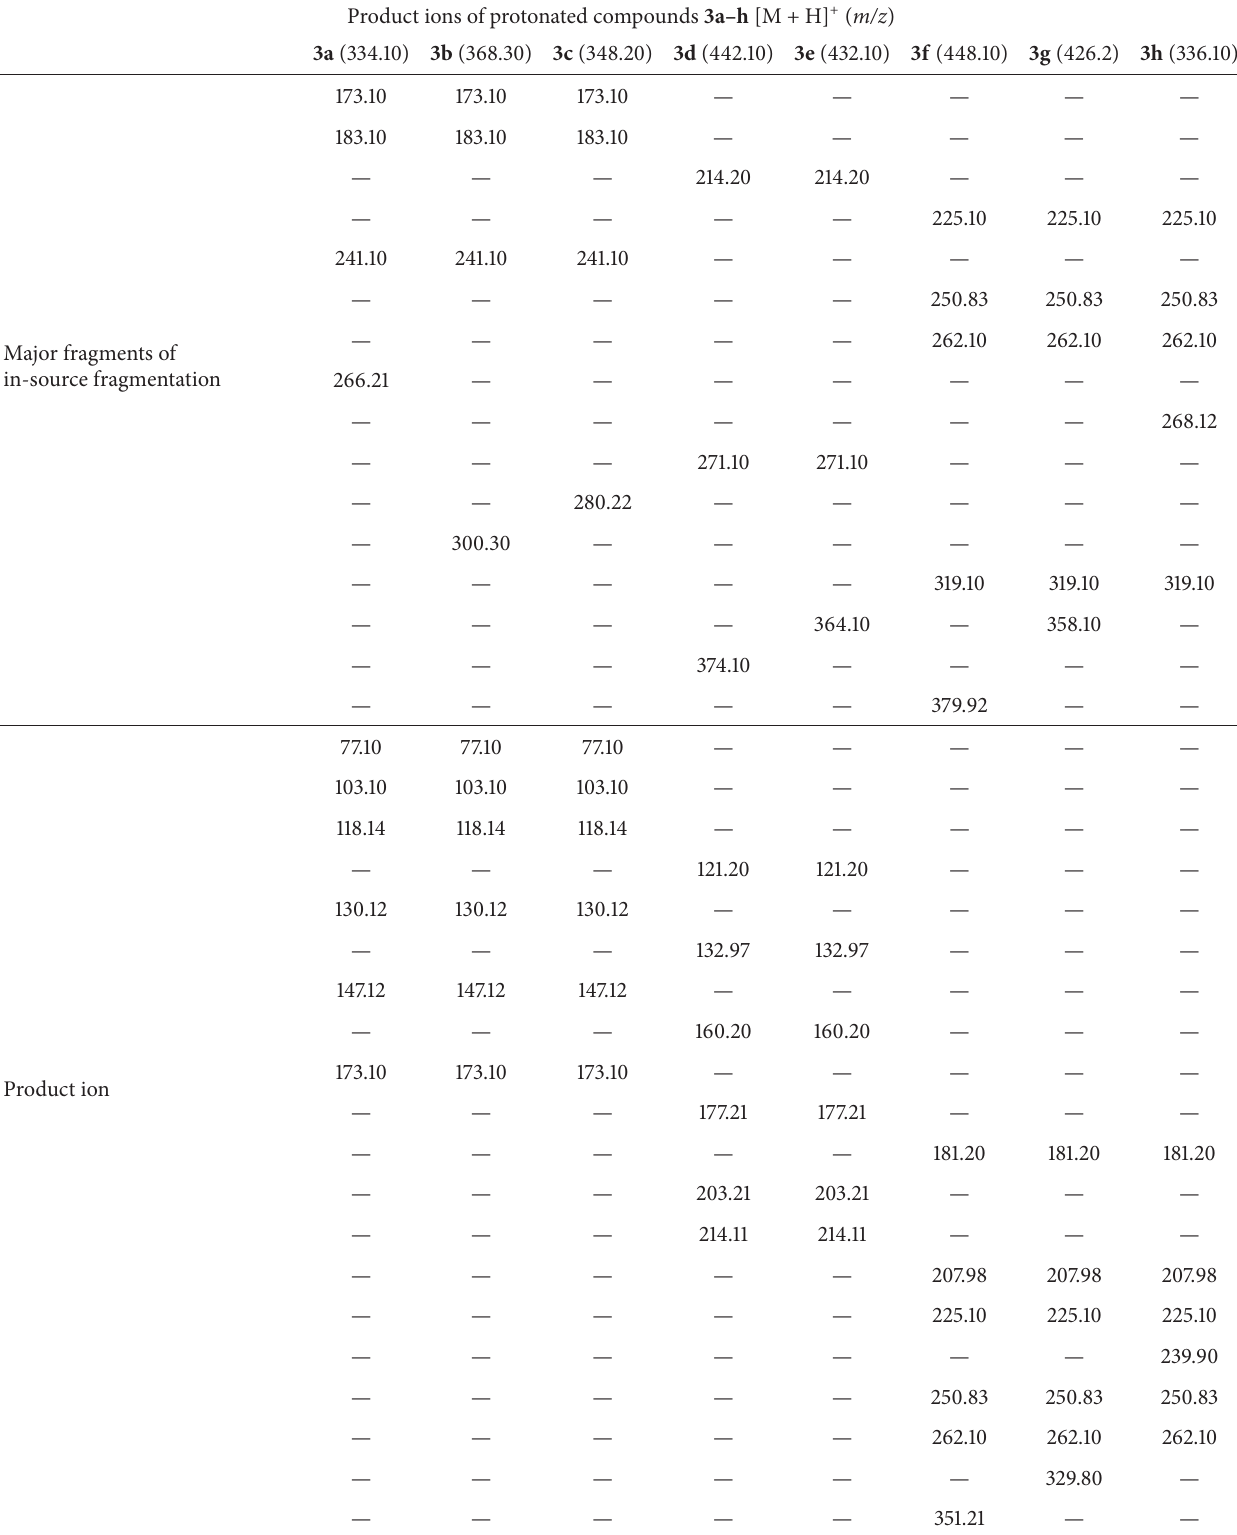
Table 1: Multistage MS data of compounds 3a–h by